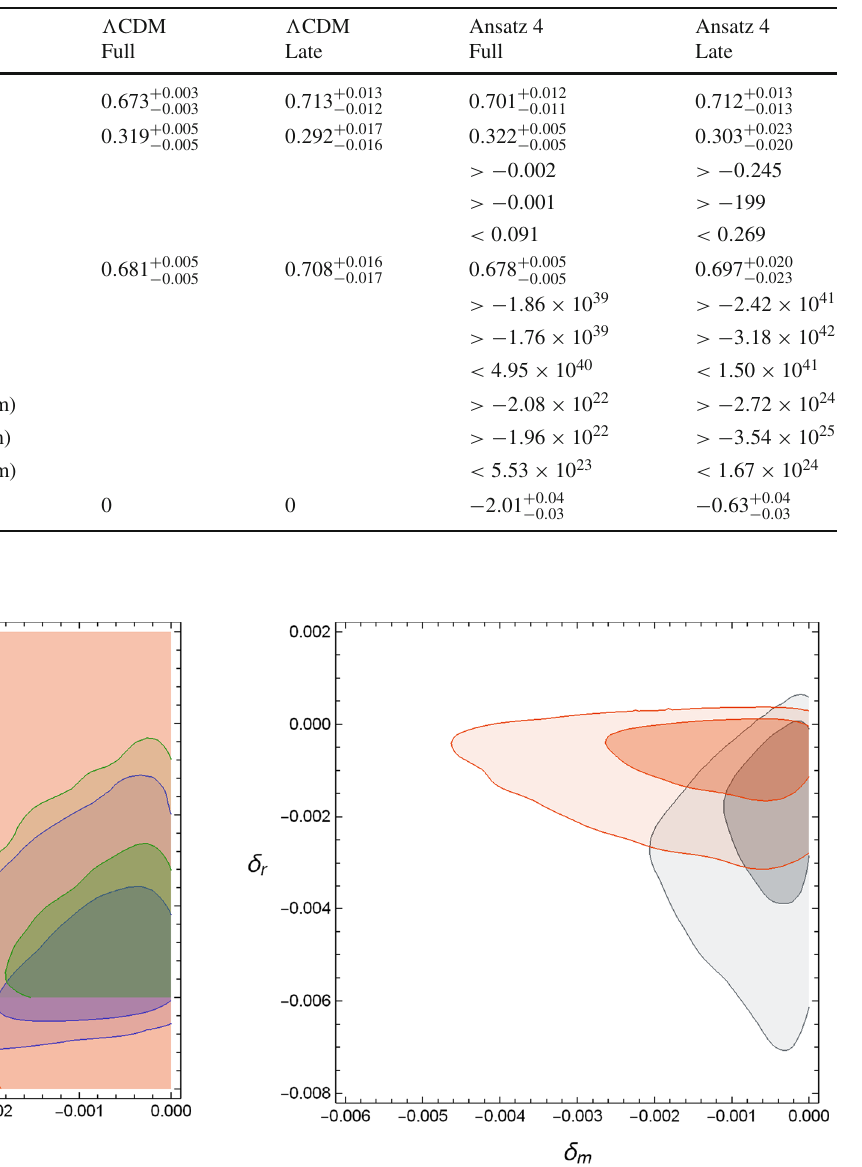
Fig. 1 1 σ and 2 σ contour plots in the parameter plane δ (cid:2) − δ m for the four ansätze (Ansatz 1 – blue; Ansatz 2 – grey; Ansatz 3 – green; Ansatz 4 – red)